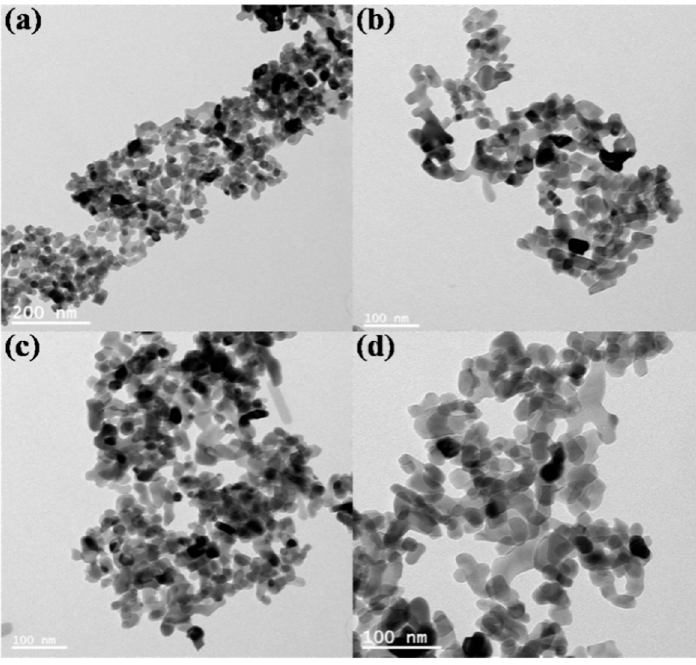
Figure 4. TEM images of ( a – d ) TU4.